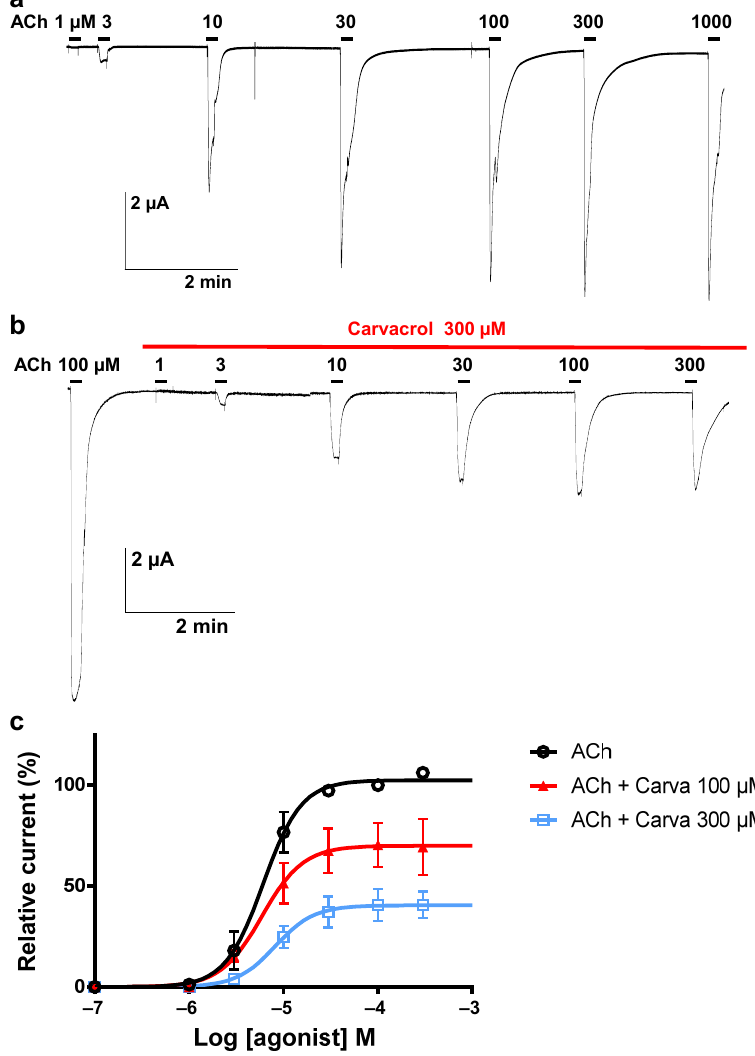
Figure 5. Carvacrol effect on the ACh concentration–response relationships for the Parascaris sp. ACR-16 N-AChR expressed in Xenopus oocytes in absence of carvacrol ( a ) or in presence of carvacrol ( b ). Representative current traces for single oocytes. The concentrations of ACh and carvacrol ( µ M) are indicated above each trace. Bars indicate drug applications: ACh was applied for 10 s, and carvacrol was applied for 11 min (red bar). ( c ) Concentration–response curves. All responses are normalized to 100 µM ACh. Results are shown as the mean ± SE ( n = 6 – 10).